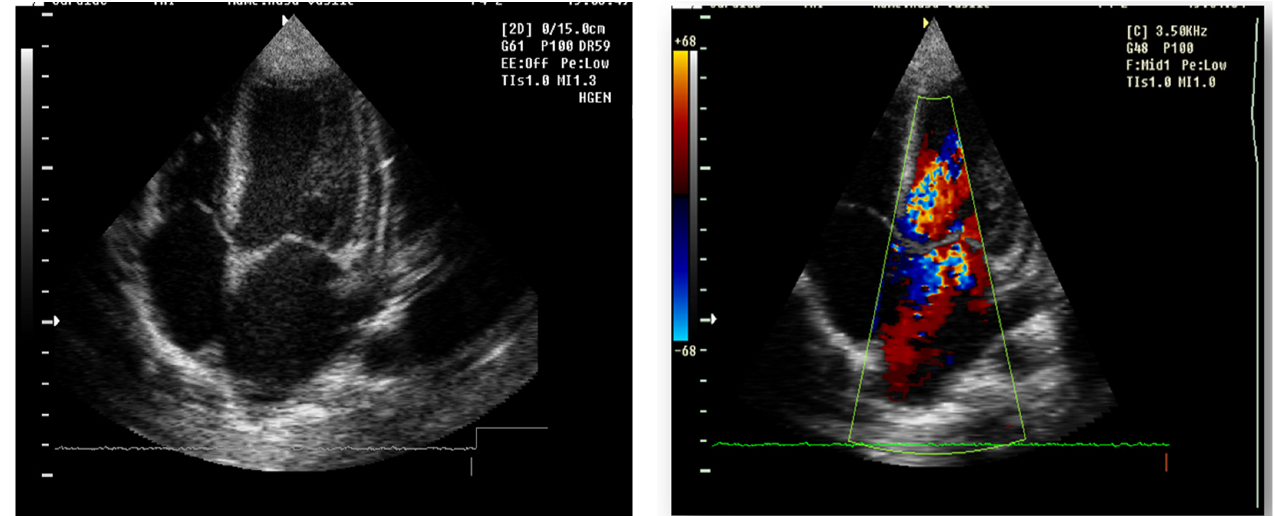
Figure 9. Echocardiography 4 chamber transthoracic apical view: echodense mitral and aortic valve, II-degree mitral regurgitation and I degree aortic regurgitation, pulmonary and tricuspid valve echodense, with I degree regurgitation. Left atrium and Left ventricle dilatation, normal kinetics, EF 70%, inferior vena cave not dilated, with inspiratory collapse, E/A > 2.